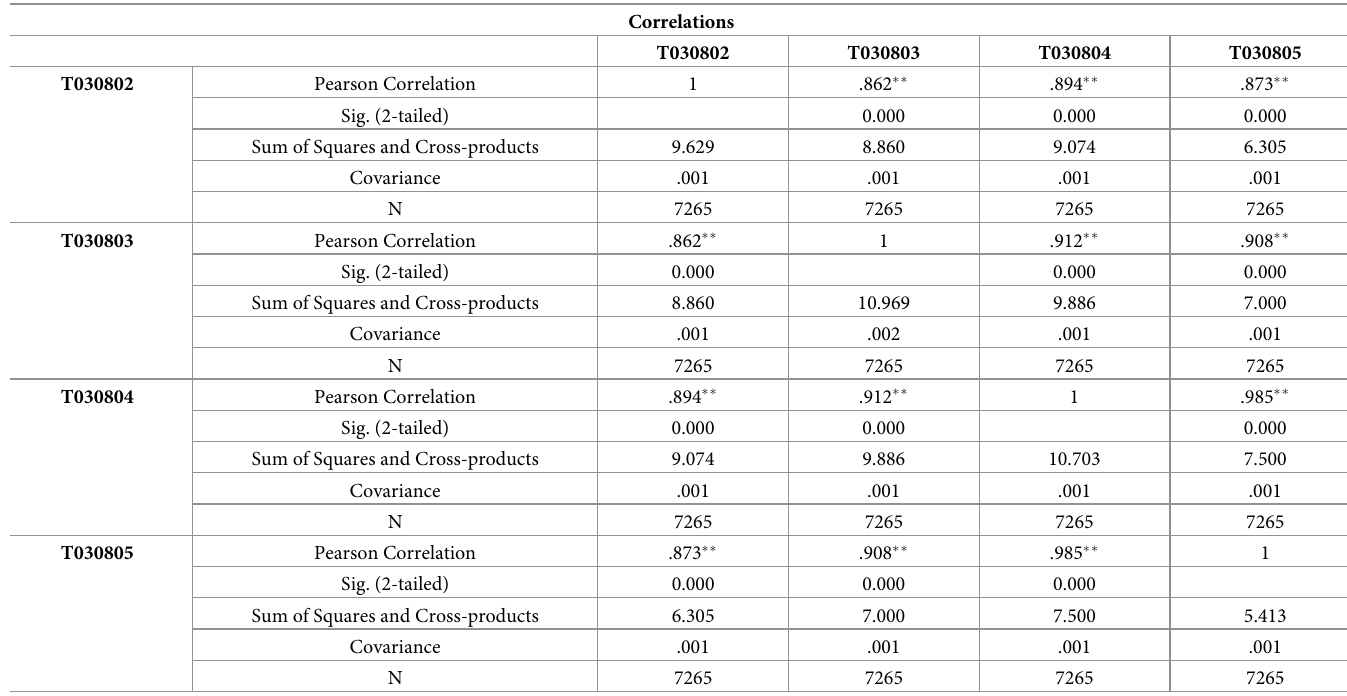
Table 5. Correlation analysis in Case study 1.